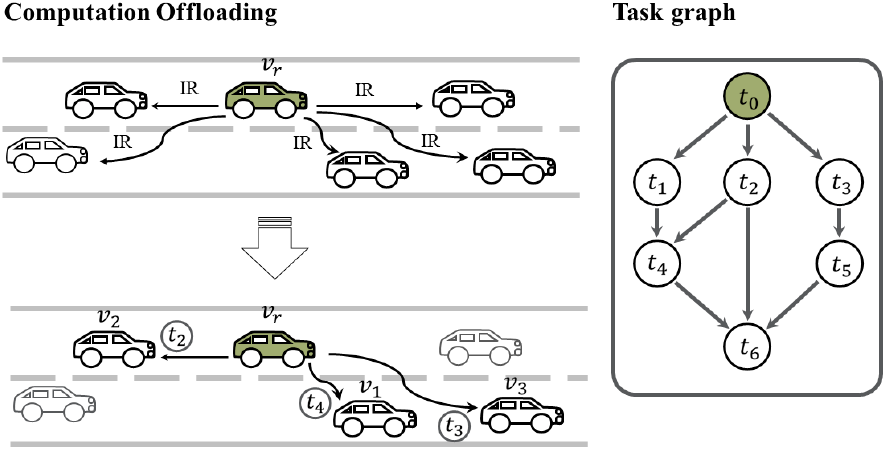
Figure 2. The operation of the VAO mechanism. Table 2. The notations and meanings.